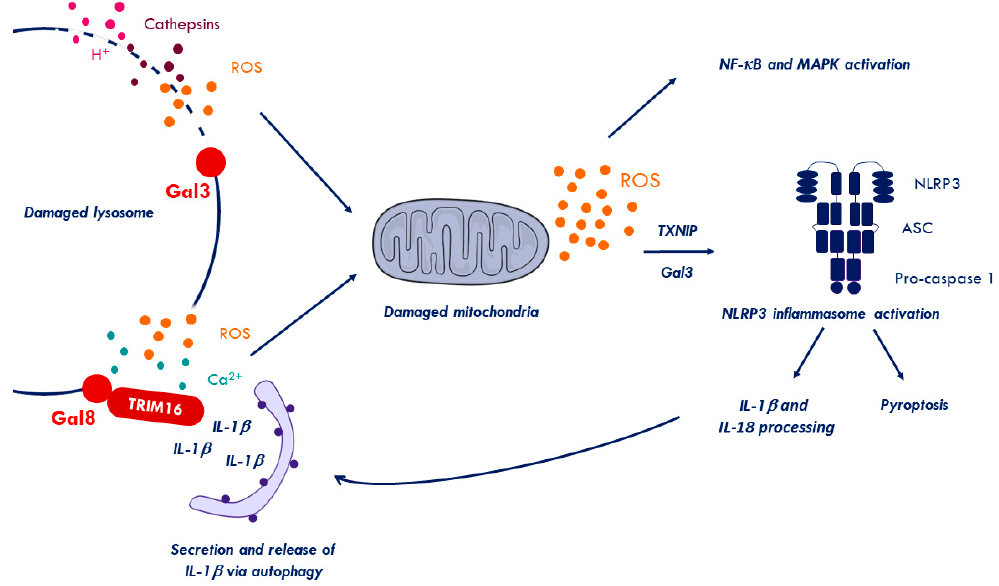
Figure 4. Membrane damage signaling. Endolysosomal rupture triggers the leakage of harmful components (e.g., ROS, H + , cathepsins or Ca 2 + ), resulting in mitochondrial damage and increased ROS production. Increasing levels of ROS activate nuclear factor-kappa B (NF- κ B) and mitogen-activated protein kinase (MAPK) signaling and triggers the release of the thioredoxin-interacting protein (TXNIP) from thioredoxin. Soluble TXNIP mediates Nod-like receptor family, pyrin domain-containing 3 (NLRP3)-inflammasomes activation and association with their adapters (ASC), thereby triggering pro-caspase conversion [149,150]. Activated inflammasomes process pro-inflammatory cytokines (IL-1 β and IL-18) and may trigger cell death through pyroptosis. Processed IL-1 β in turn can be recruited by Gal8 and TRIM16, that coordinate the autophagic machinery to secrete IL-1 β via an unconventional secretory pathway [105,151]. Abbreviations: Gal3, galectin3; Gal8, galectin8; ROS, reactive oxygen species.